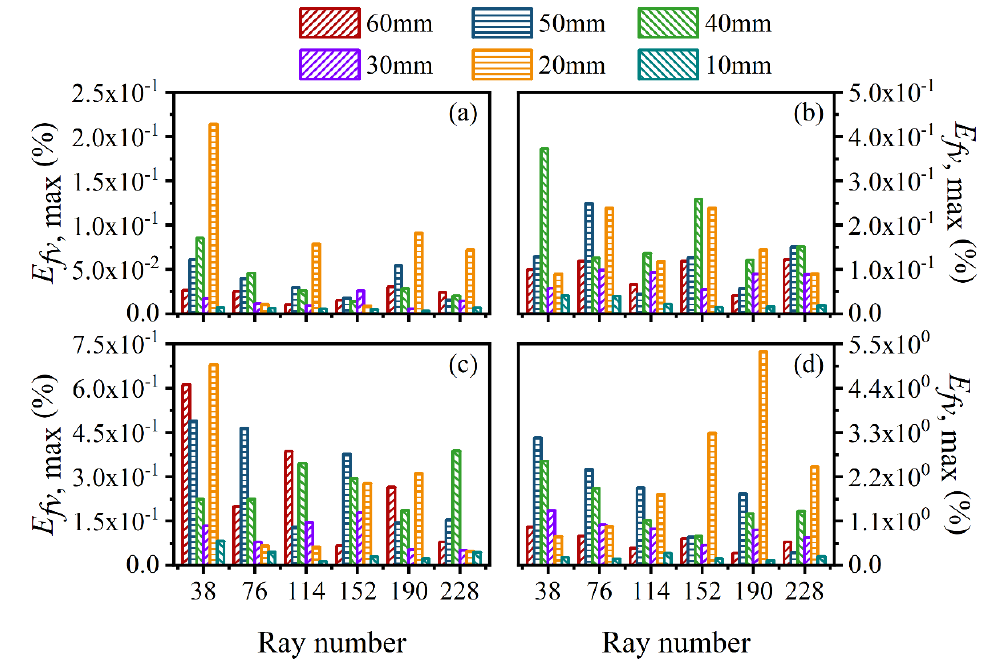
Figure 16. The maximum relative reconstruction error for soot volume fraction at the main cross- sections in sooting regions. ( a ) SNR = 80 dB; ( b ) SNR = 65 dB; ( c ) SNR = 60 dB; ( d ) SNR = 46 dB.